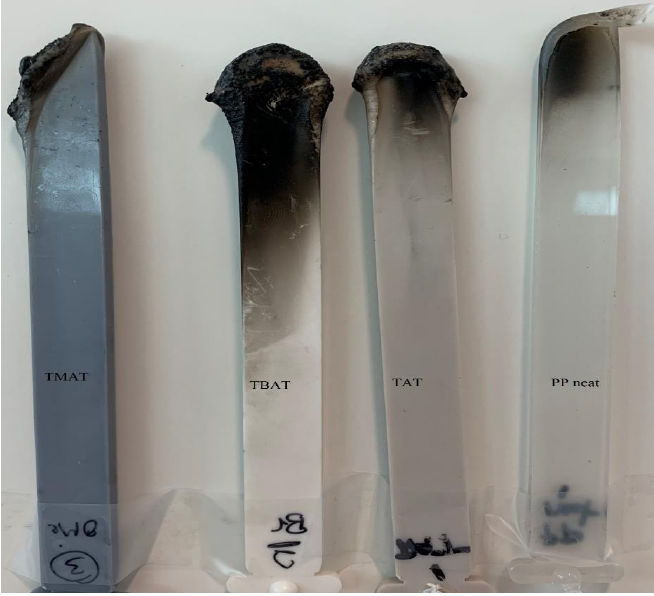
Figure 4. PP1, PP2, and PP3 specimens after UL94 tests.